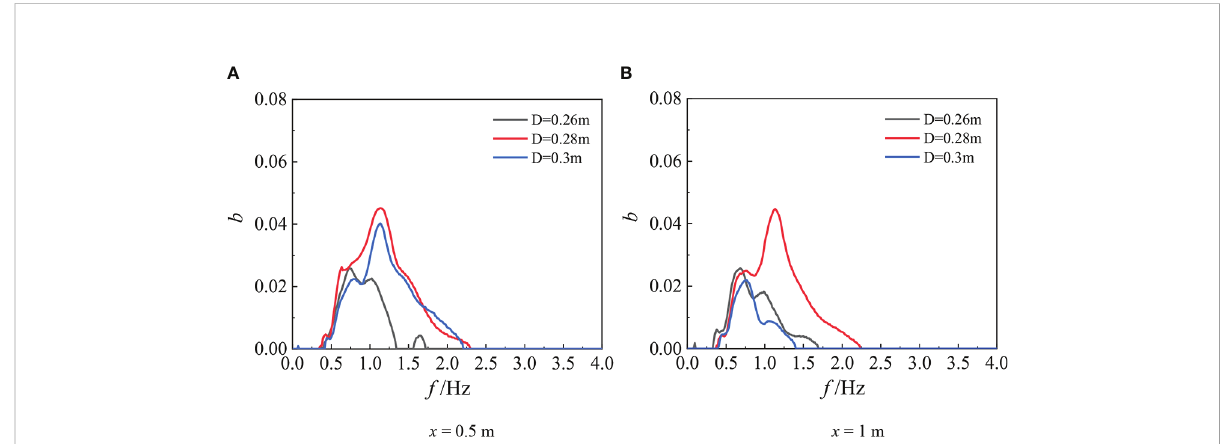
FIGURE 13 Comparison of summed bicoherence under different water depths (M1, H i = 0.043 m, T = 1.5 s) (A) x = 0.5 m (B) x = 1